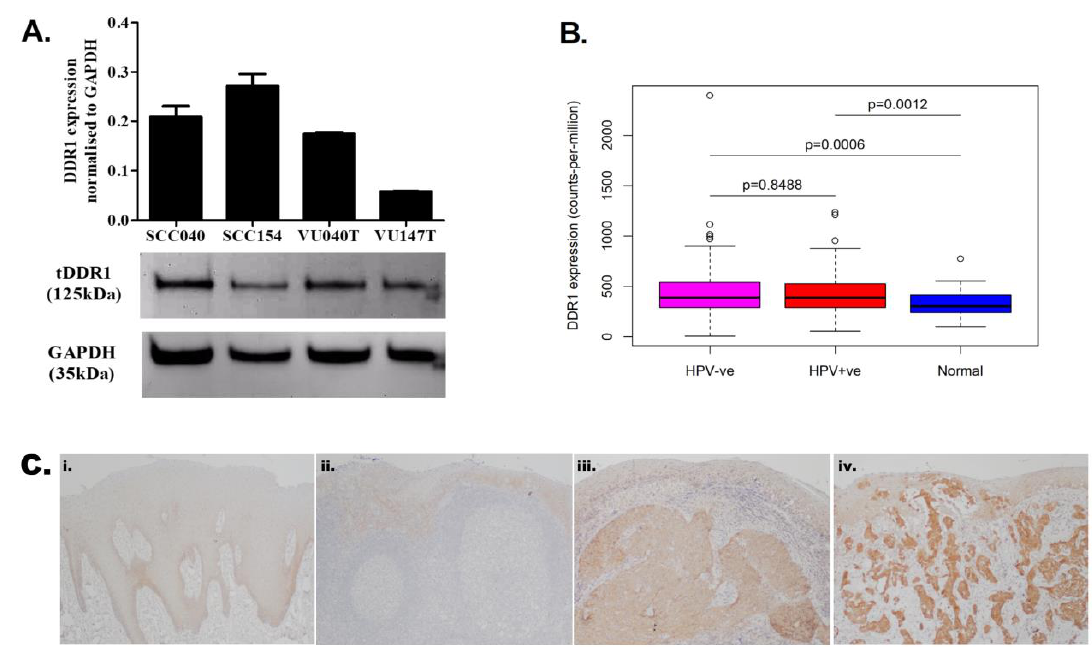
Figure 3. Discoidin domain receptor 1 (DDR1) was over-expressed in head and neck squamous cell carcinoma (HNSCC). ( A ) DDR1 is readily detectable in HNSCC cell lines by RT-qPCR and western blotting. ( B ) Analysis of The Cancer Genome Atlas (TCGA) expression data revealed that DDR1 is significantly over-expressed in tumours relative to normal samples. There was no statistically significant difference in DDR1 expression between human papillomavirus (HPV)-negative and HPV-positive tumours. ( C ) Immunohistochemical analysis of DDR1 protein revealed that normal epithelium showed weak cytoplasmic staining (i and ii), whilst the majority of squamous cell carcinomas (8 of 12) showed increased DDR1 expression in comparison to normal epithelium (iii and iv). (Original magnification × 100).